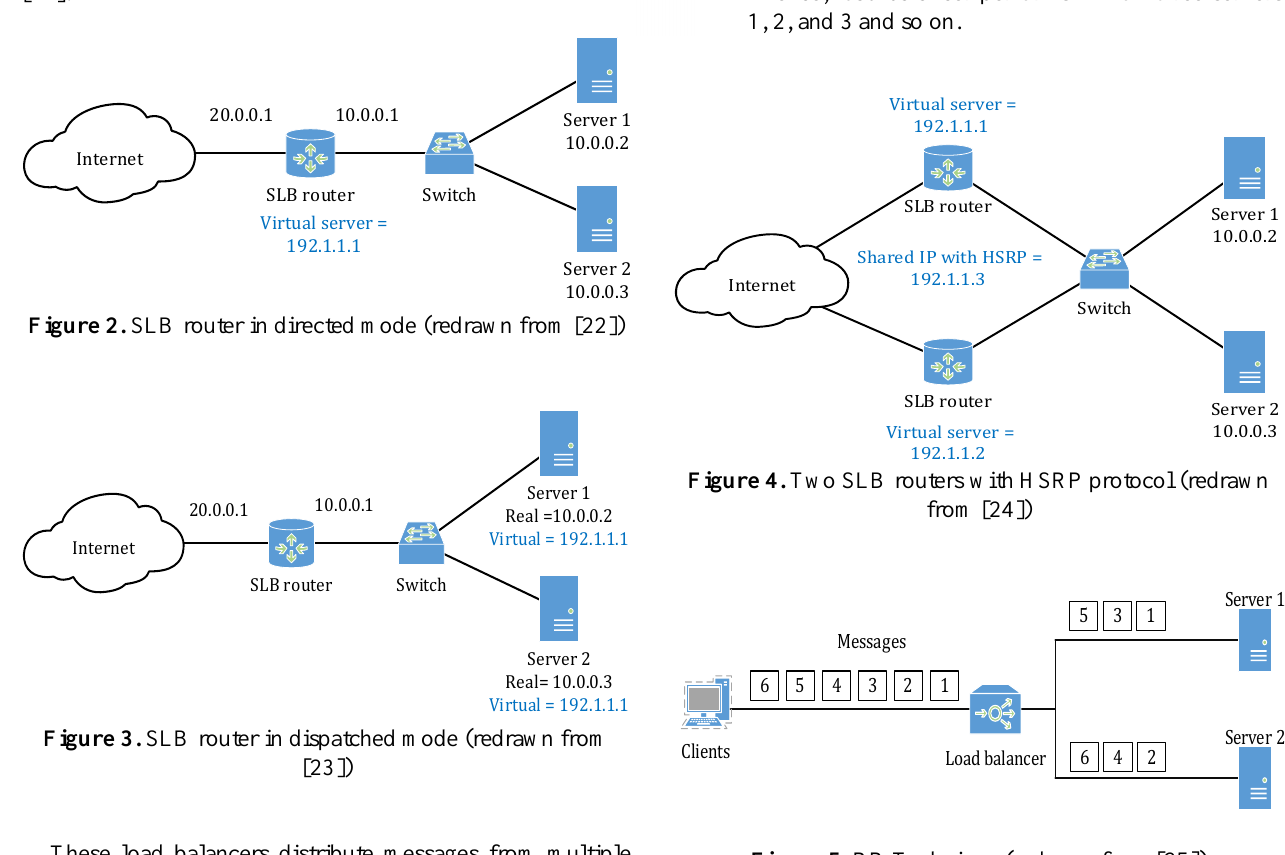
Figure 5. RR Technique (redrawn from [25])